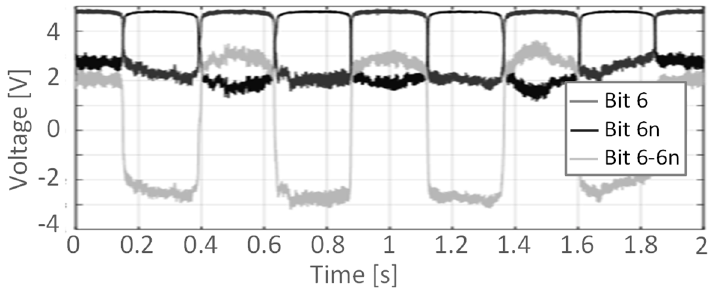
Figure 20. Example of the Gray code encoder signals (bit 6) for one revolution (360°).